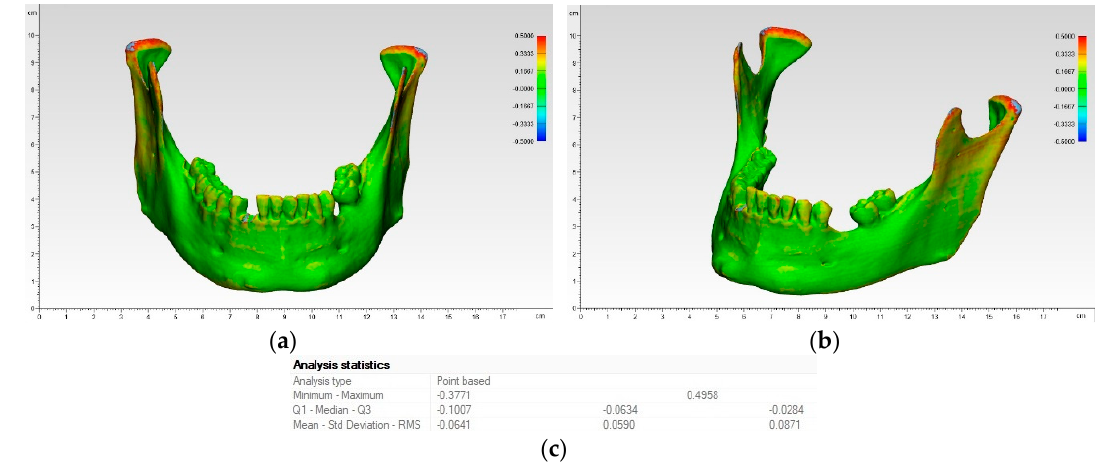
Figure 8. Heat map of mandibular model printed in SLS technology: ( a ) front view; ( b ) side view; ( c )